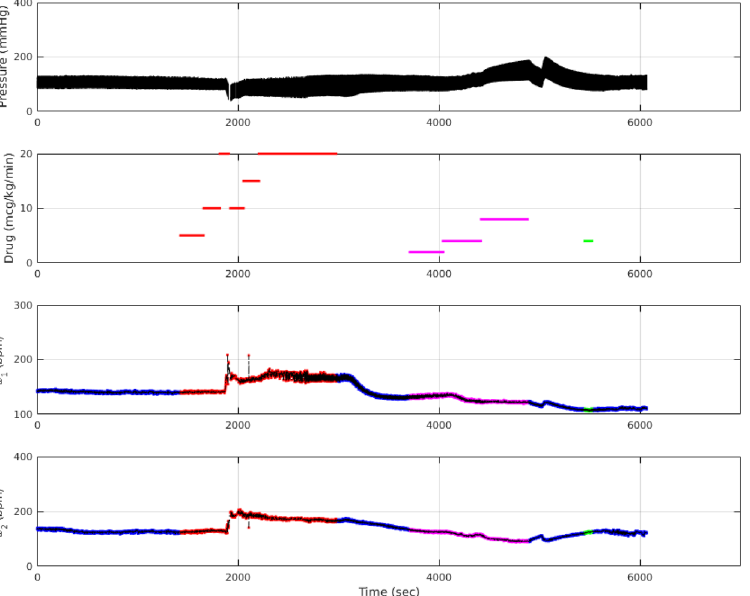
Figure 4. Drug effects on ω 1 and ω 2 . First Panel: The measured aortic pressure waveform recorded in time. Second Panel: Dosage of dobutamine (in red), phenylephrine (in purple), and nitroglycerin (in green) during the aortic pressure measurement. Third Panel: Changes of ω 1 in units of bit per minute (bpm) over the measurement time. Each drug effect is projected with its corresponding color, for the fast IF algorithm. No drug areas are in blue, for the fast IF algorithm. The brute-force algorithm results are shown in dashed black line. Fourth Panel: Changes of ω 2 in units of bpm over the measurement time. Each drug effect is projected with its corresponding color, for the fast IF algorithm. No drug areas are in blue, for the fast IF algorithm. The brute- force algorithm results are shown in dashed black